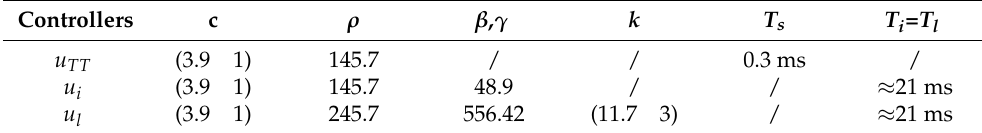
Table 1. Controller parameters, u TT , u i , u l